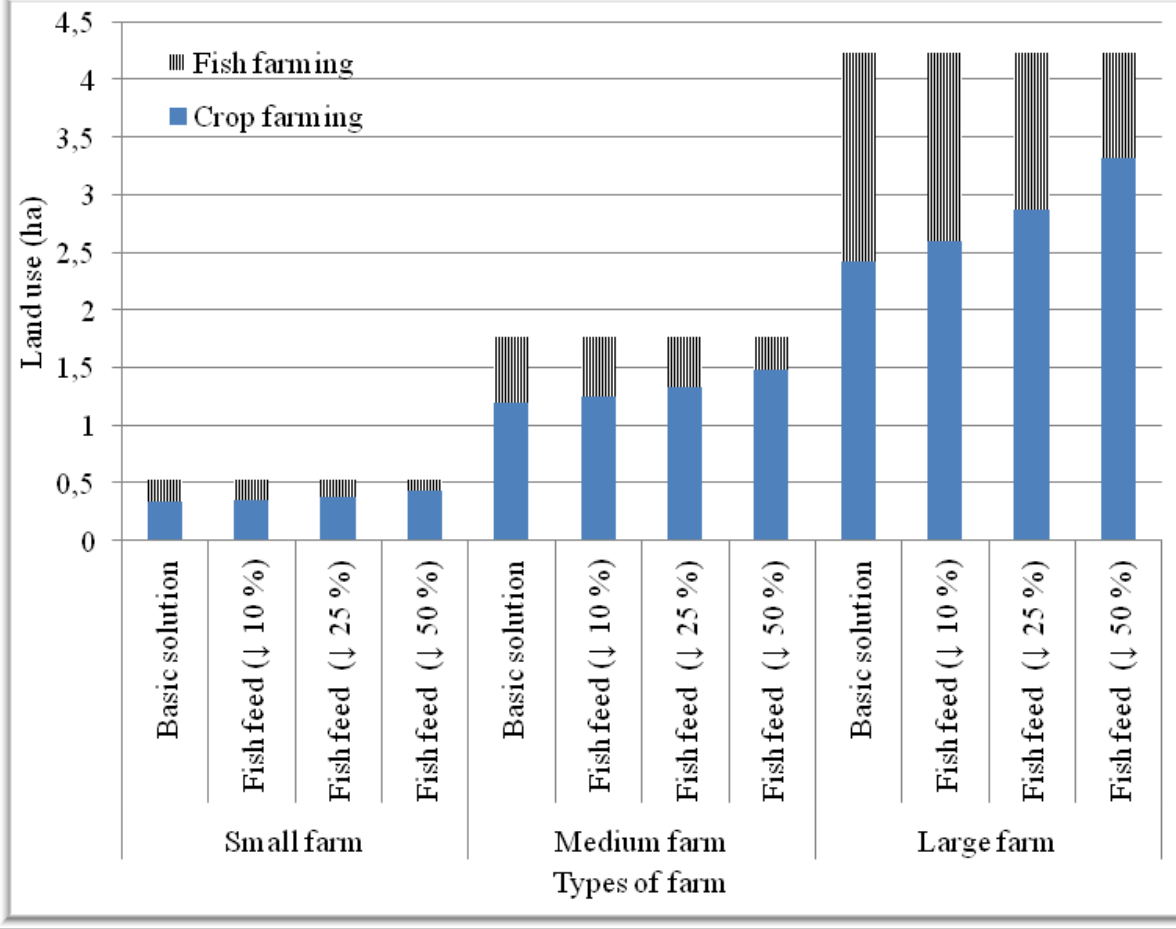
Fig. 3: Less fish feed availability and land use pattern of the farmers. Source: Author’s